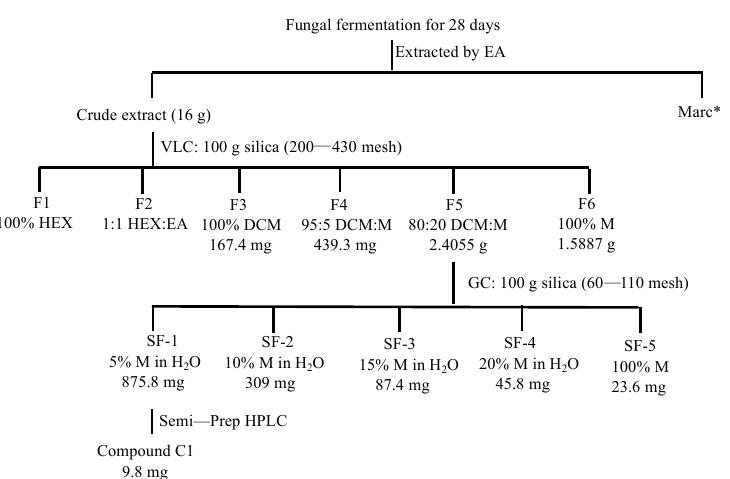
Figure 2. Schematic presentation of isolation of pure compounds from P. janthinellum . Marc*: residue incubated and discarded after extraction with ethyl acetate. VLC: Vacuum Liquid Chromatography; GC: Gravity column; EA: ethyl acetate; HEX: hexane; DCM: dichloromethane; M: methanol. Table 1. Inhibition activities of fractions on P. falciparum asexual stage proliferation. The Inhibitory Ratio of the Growth of Asexual Stage of Samples P. falciparum (%) (30 µg/mL)